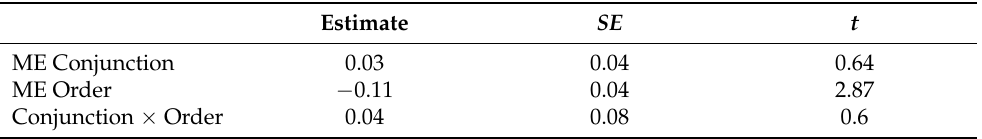
Table 7. Summary of the statistical analyses of participants’ response times for the number conflict conditions, Experiment